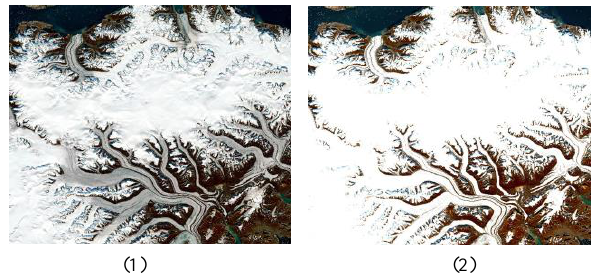
Figure 3: (1) LuxCarta downscaled 8bit, (2) ESA downscaled 8bit.